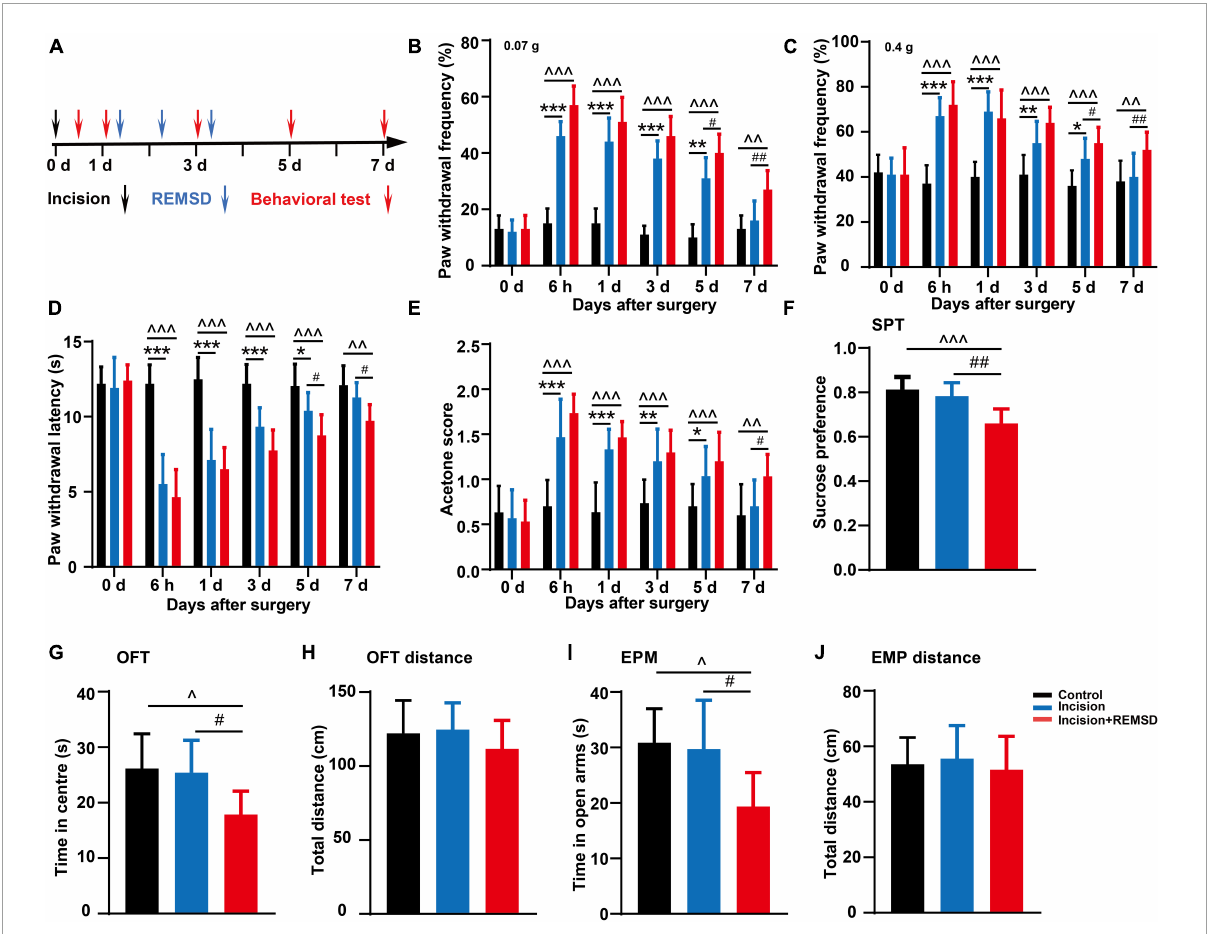
FIGURE1 Effect of incision and perioperative rapid eye movement sleep deprivation (REMSD) on postsurgical pain in mice. (A) Schematic diagram of the experimental schedule. (B–D) Mechanical paw withdrawal frequency in response to 0.07 g von Frey (B) , 0.4 g von Frey (C) , and paw withdrawal latency in response to thermal stimulus (D) at different time points. (E) Measurements of cold sensitivity by acetone testing. (F–J) The anxiety-like behavioral tests on the 7 days after surgery. (F) Sucrose preference test (SPT). (G,H) Open field test (OFT) [ (G) time spent in the center zone; (H) total distance in the box]. (I,J) Elevated plus maze (EPM) [ (I) time spent in the open arms; (J) total distance of the maze]. Significances of the corresponding time points were assessed by one-way ANOVA with post hoc multiple comparisons test in panels (B–E) , and ordinary one-way ANOVA post hoc multiple comparisons test between groups in panels (F–J) . Control vs. incision, * P < 0.05, ** P < 0.01, *** P < 0.001. Control vs. incision + REMSD, ∧ P < 0.05, ∧∧ P < 0.01, ∧∧∧ P < 0.001. Incision vs. incision + REMSD, # P < 0.05, ## P < 0.01. n = 8 in each